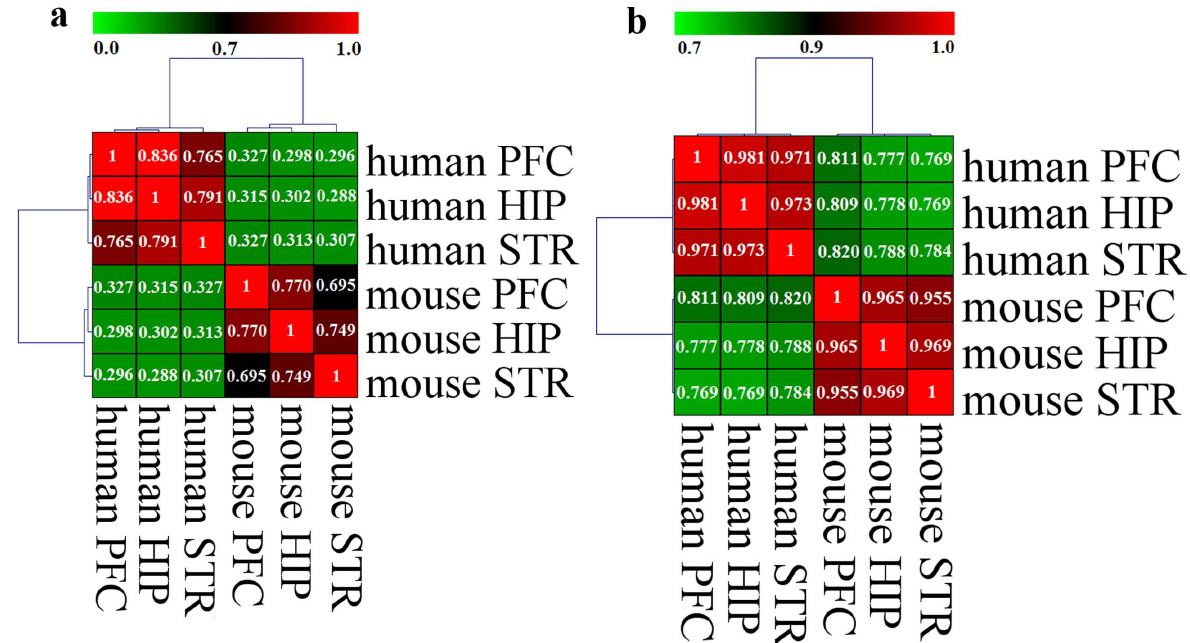
Fig 2. Overlapping ratio and semantic similarity analyses. (a) Comparison of the overlappingratios. The overlapping ratio was defined as the number of the intersection divided by the number of the union of two BP term sets. The overlap significance was determinedusing the one-tailedFisher’s exact test. Hierarchical clustering with a Pearson distance metric and average linkagemethod was performed based on the overlappingratios. (b) Comparison of the semantic similarities. Semantic similarity between two sets of BP terms was measured using mgoSim function from an R package termed GOSemSim. The method parameter was set as “Wang” and the GO used in measurement was restricted by assigningthe corresponding parameter to ‘BP’. The similarity score is between 0 and 1. The higher the score, the more similarity between two sets of BP terms. Hierarchicalclusteringwith a Pearson distance metric and average linkage method was performed based on the calculated similarity